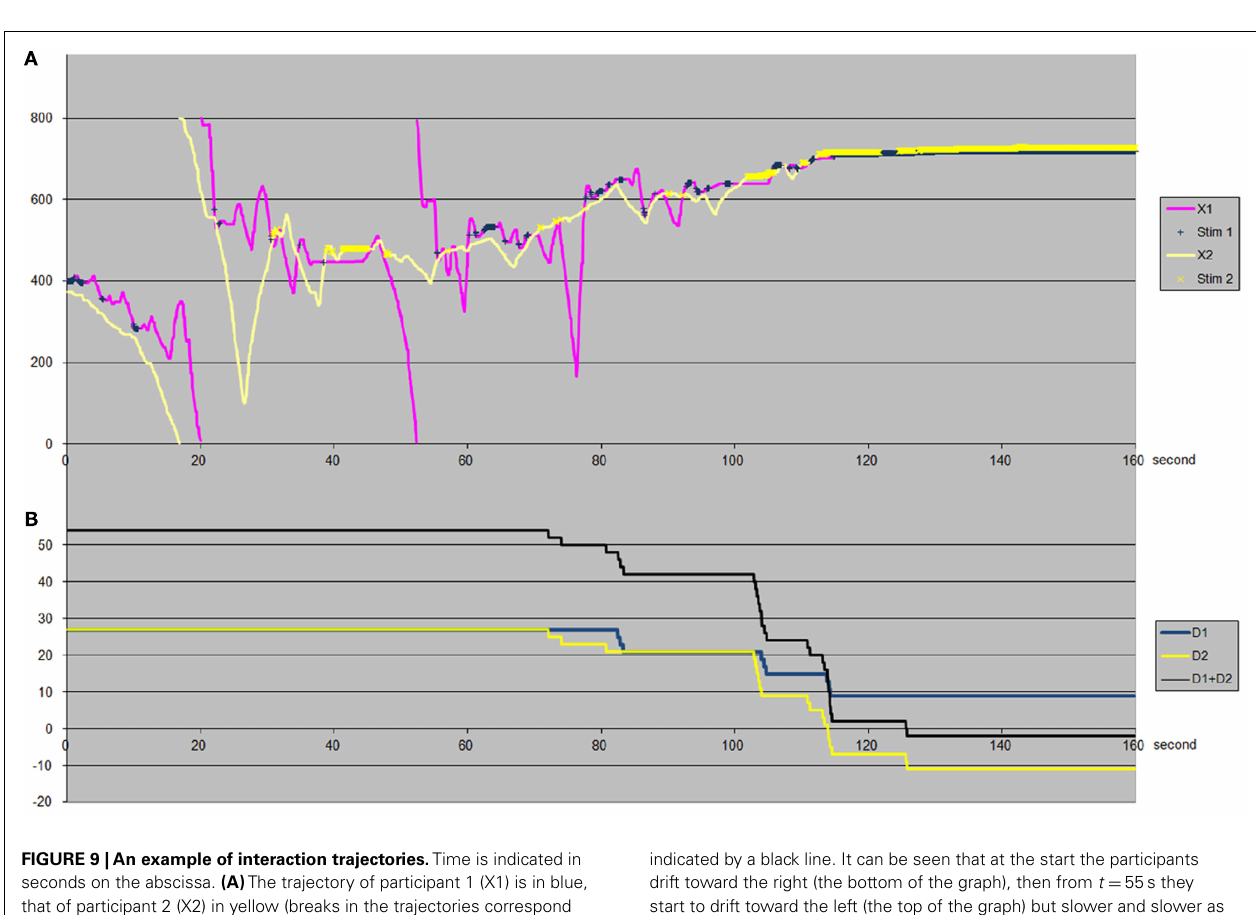
FIGURE 9 |An example of interaction trajectories. Time is indicated in seconds on the abscissa. (A) The trajectory of participant 1 (X1) is in blue, that of participant 2 (X2) in yellow (breaks in the trajectories correspond simply to passages in the torus). Stimulations received are marked by crosses on the trajectory. (B) The displacement between receptor field and body-object for participant 1, D 1, is in thick yellow, and that of participant 2, D 2, in thick blue.The sum of the displacements ( D 1 + D 2) is